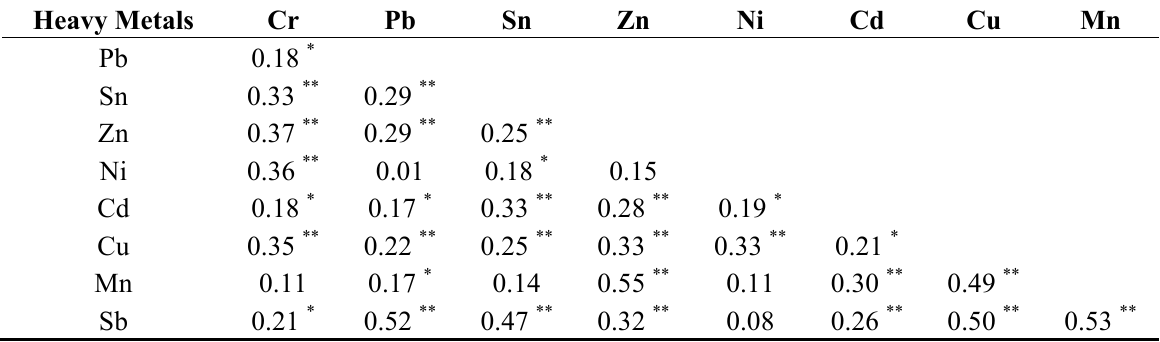
Table 1. Spearman rank correlation coefficients between effluents of nine heavy metals.